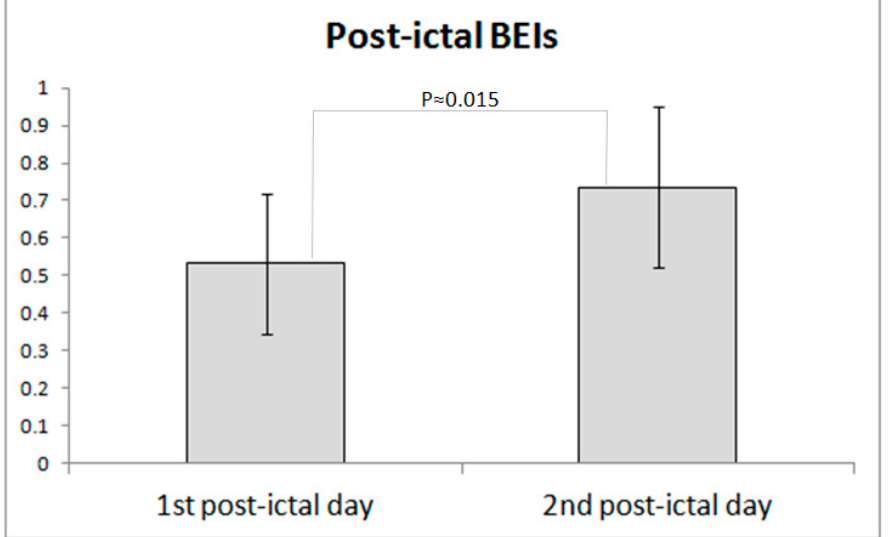
Figure 3. Comparison of the average BEI for the first and second post-ictal day. A higher BEI was observed in the second compared with the first post-ictal day ( p = 0.015, paired t -test).